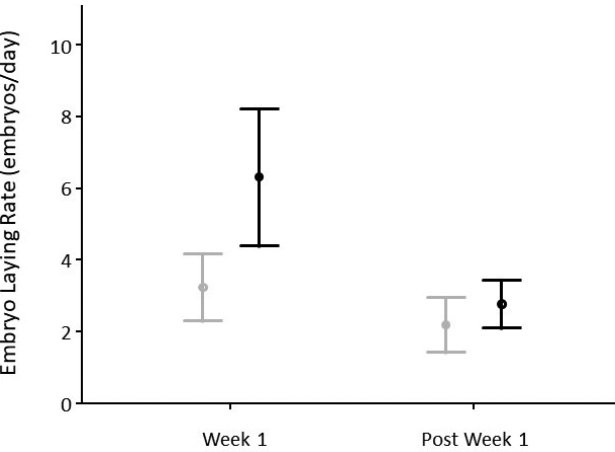
Fig. 4. Mean (±SE) embryo laying rate during: the first week fol- lowing treatment (Week 1), and the subsequent weeks following treatment (Post Week 1) of females who experienced either low- (grey symbols) or high- (black symbols) quality calling